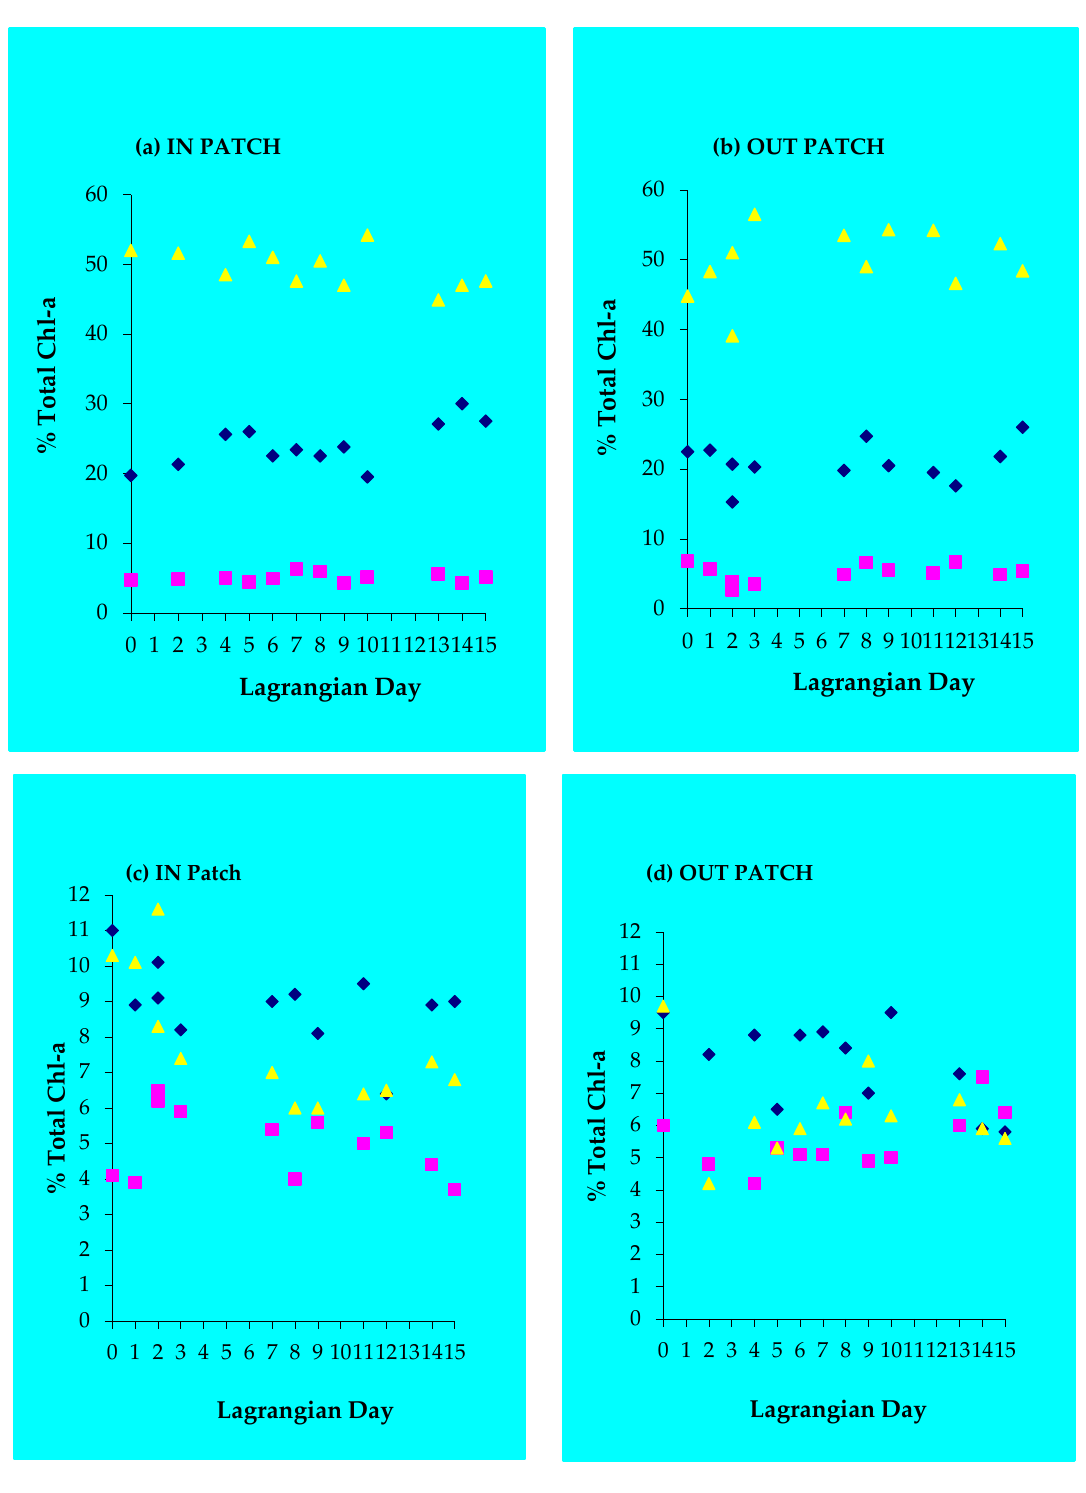
Figure 7. Percentage (%) of total Chl a (determined from CHEMTAX analysis of marker pigments) in prasinophytes, dinoflagellates, and hapto8s over Lagrangian day for the ( a ) IN patch and ( b ) OUT patch (yellow triangles = hapto8; blue diamonds = prasinophytes; pink squares = dinoflagellates). ( c ) IN patch and ( d ) OUT patch (yellow triangles = cyanobacteria; blue diamonds = chlorophytes; pink squares = cryptophytes).